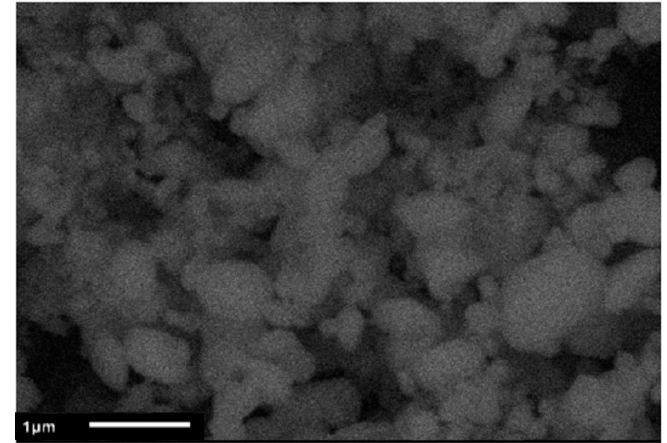
Figure 2. SEM image of tin oxide (SnO 2 ) nanoparticles annealed at 1000 °C.